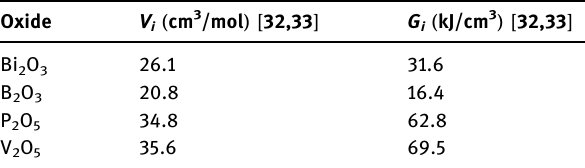
Table 2: Packing density factor ( V i ) and dissociation/bond